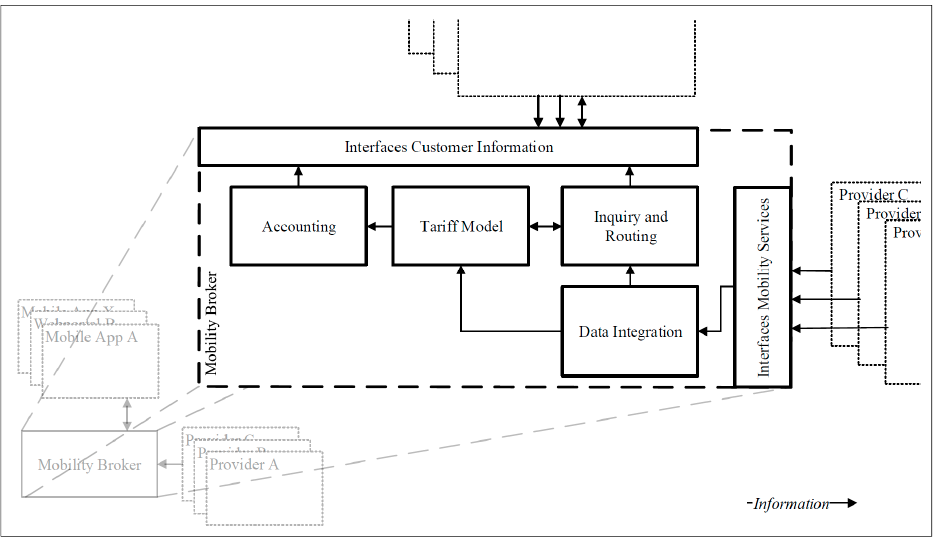
Figure 4. Mobility broker architecture. Reproduced from Beutel et al. [23].